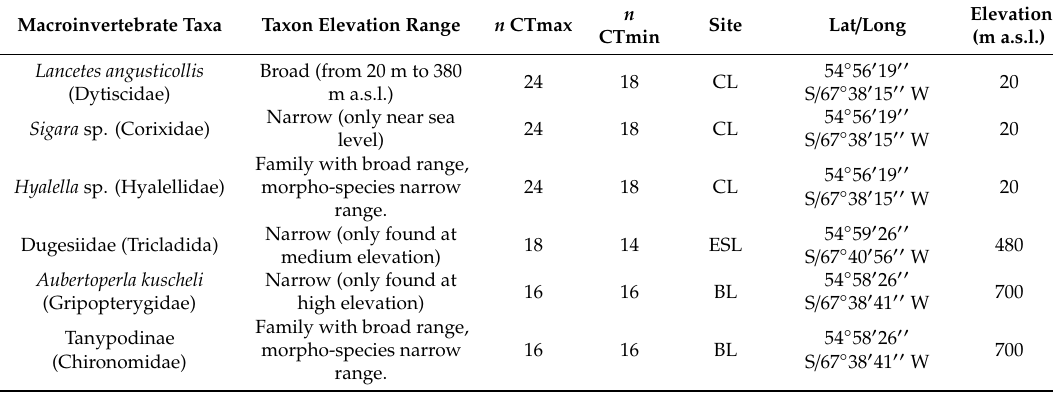
Table 1. Number of individuals per tested taxon and their collection sites within the R ó balo river watershed on Navarino Island, southern Chile. CL = Castor Lagoon, ESL = el Salto Lagoon, BL = Bandera Lagoon. Macroinvertebrate